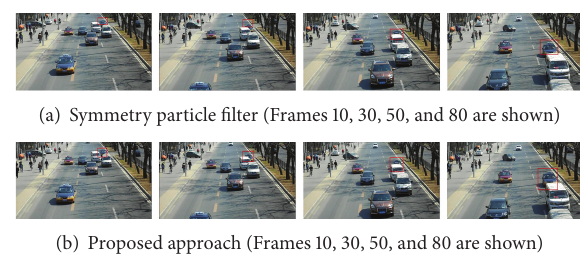
Figure 4: Tracking under partial occlusion.